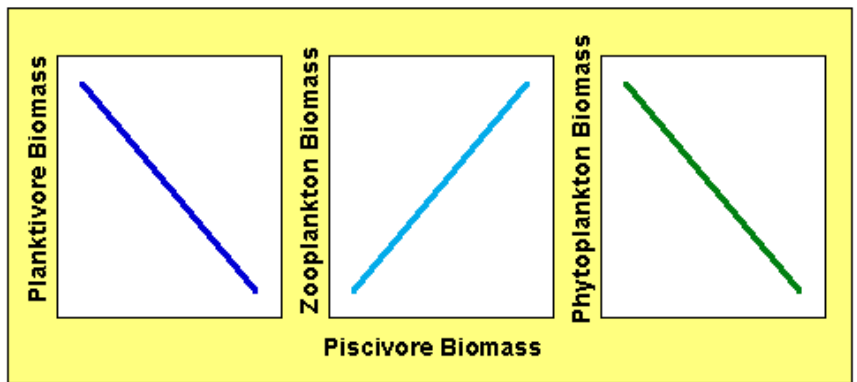
FIGURE 2 . The trophic cascade hypothesis showing predicted effects of increasing piscivore abundance on planktivorous fish, zooplankton, and phytoplankton. Modified from Carpenter et